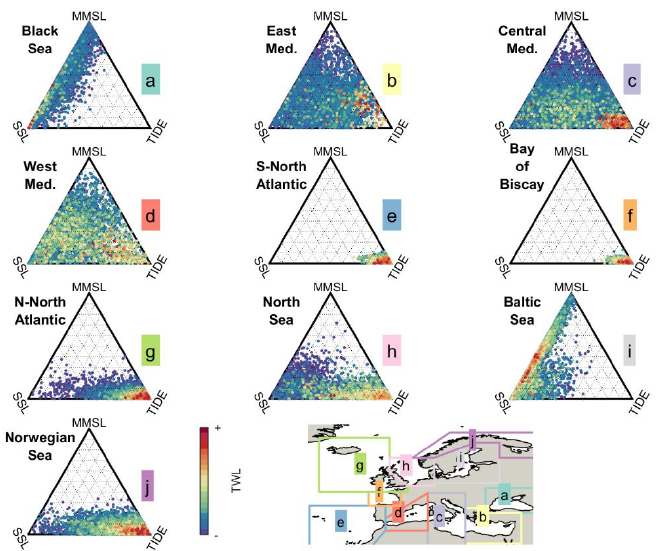
Figure 6. Fraction of components’ variance in the extreme total water level (>95th percentile) along the coastline (closest 1° × 1° tile) of each oceanographic region (Figure 6a to Figure 6j) considering TIDE, SSL and MMSL. Warm/cold colour indicates bigger/smaller extreme total water levels (ETWLs).